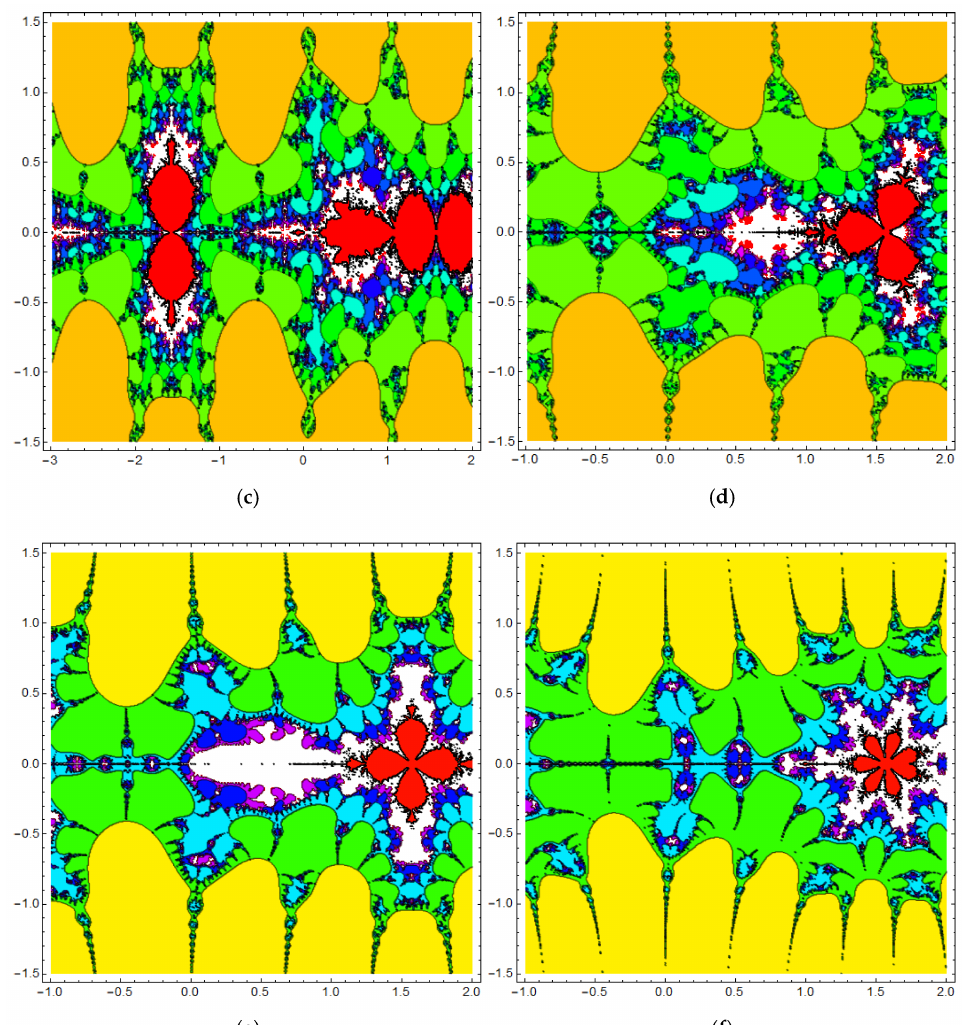
Figure 4. The Mandelbrot sets generated by the generalized fractional cosine map at α = 0.75, where